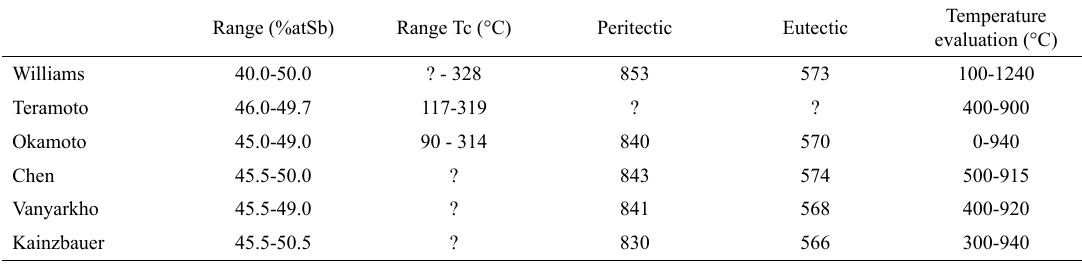
Table 1. MnSb's phase limits and temperature reactions Range